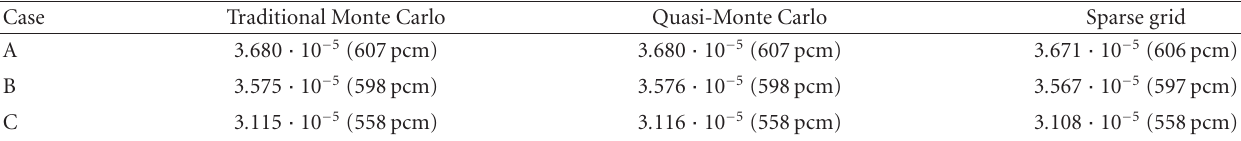
Table 3: Estimated uncertainty of the infinite multiplication factor in terms of variance and standard deviation (given in parenthesis).